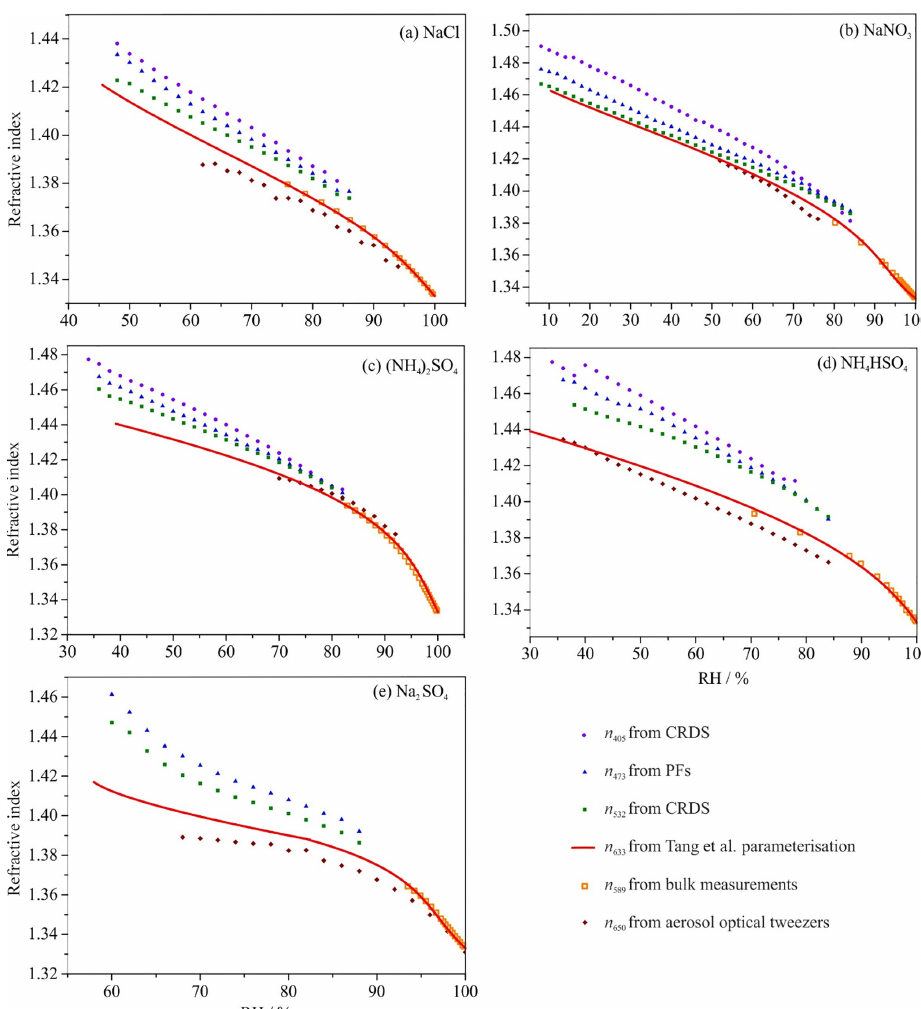
Figure 5. The average n λ variations with RH for aqueous droplets containing the inorganic solutes of interest. The uncertainties in n λ have not been included here for clarity; they are listed in Table